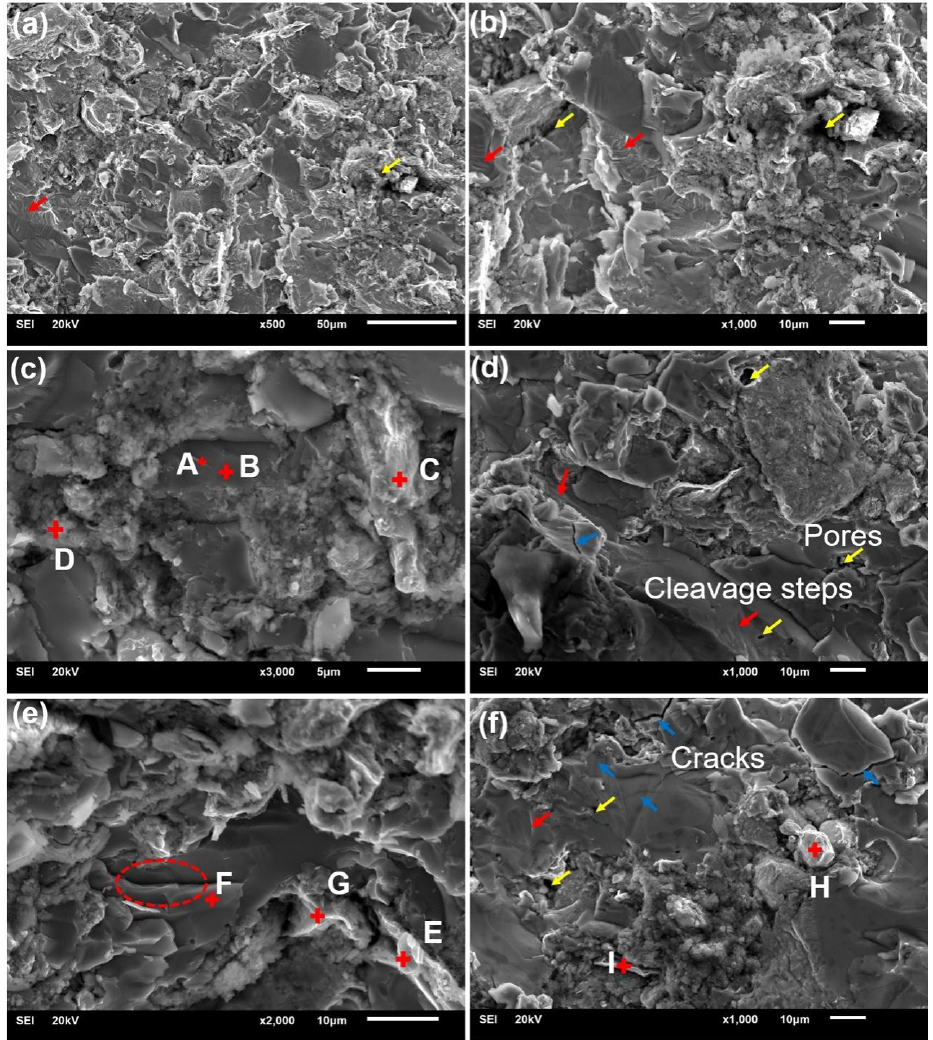
Figure 11. SEM micrographs of shear fracture surfaces of ( a ) the titanium alloy/HA nanocomposites; ( b , c ) the 0.5-CNTs nanocomposites; and ( d , e ) the 0.5-GNFs nanocomposites; ( f ) the 0.4 CNTs/0.1 GNFs nanocomposites respectively. Table 5. The EDS results (at. %) for regions A-I in Figure11.